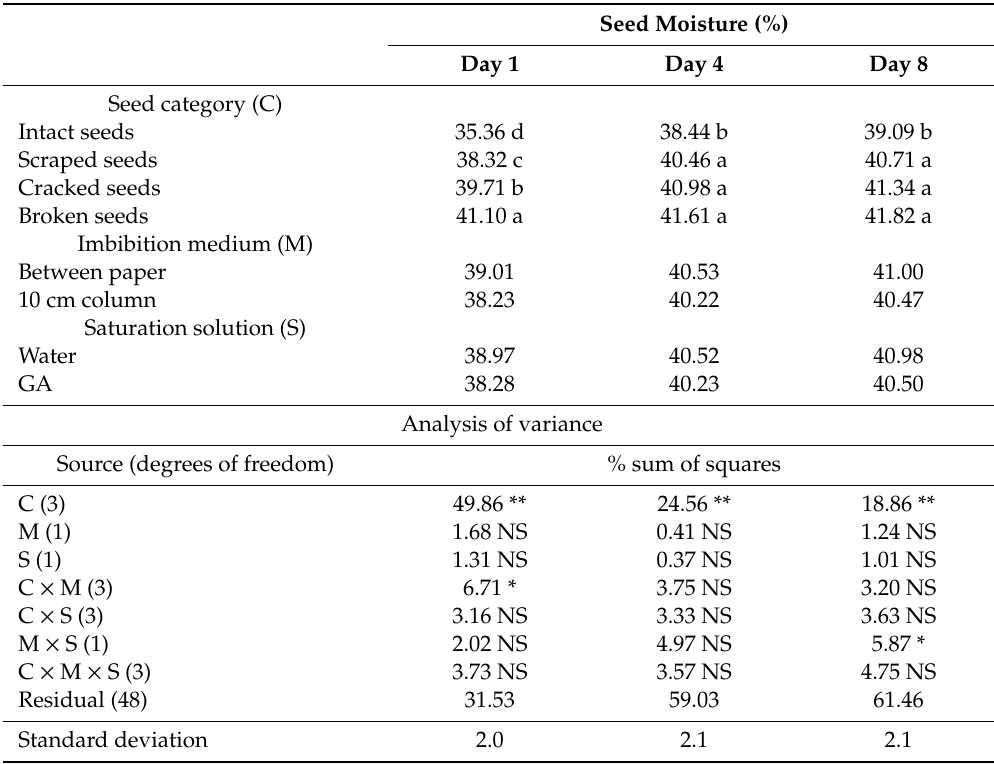
Table 3. E ff ects of the caper seed category, imbibition medium, and solution on the seed water content (%) after 1, 4, and 8 days of soaking. Mean values.